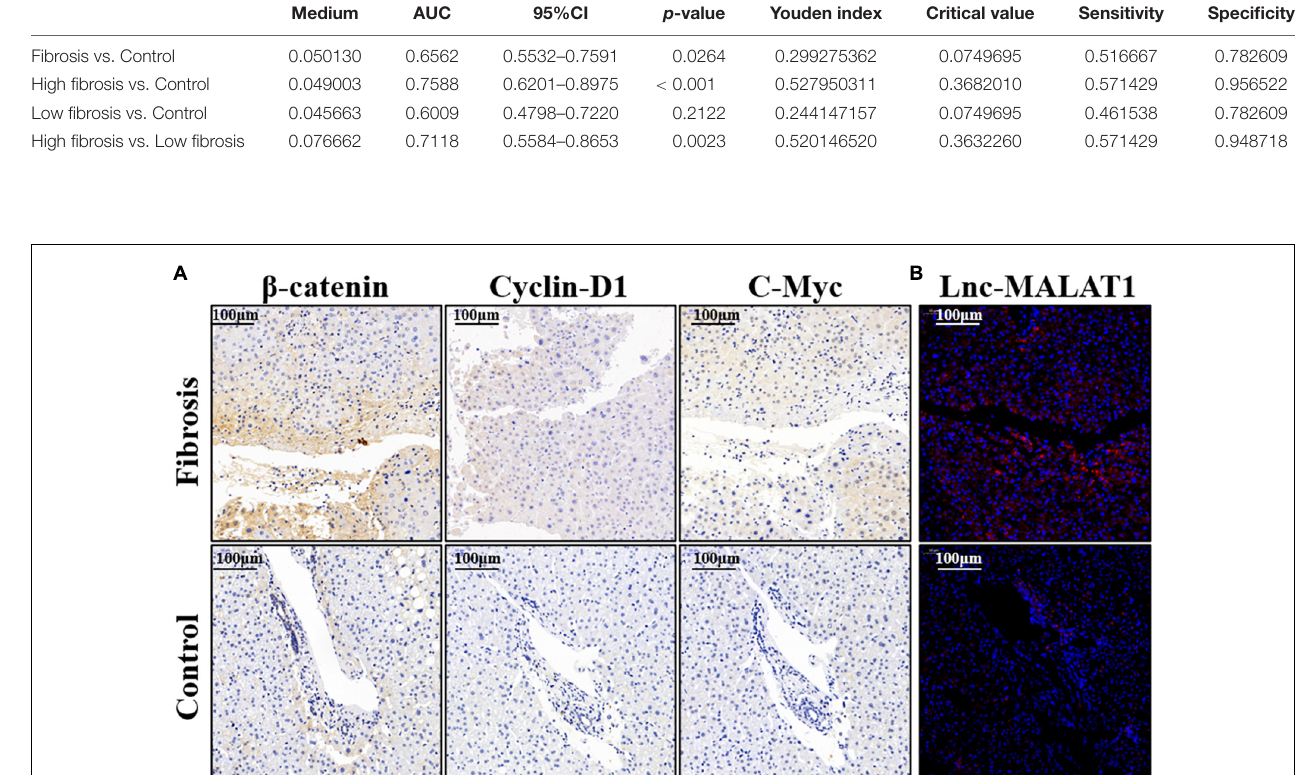
Frontiers in Physiology |